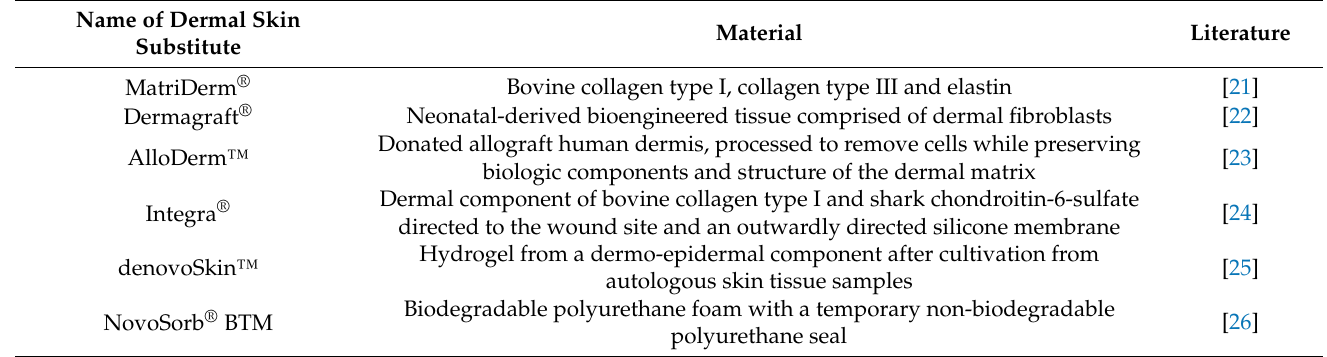
Table 1. Overview of an exemplary selection of dermal skin